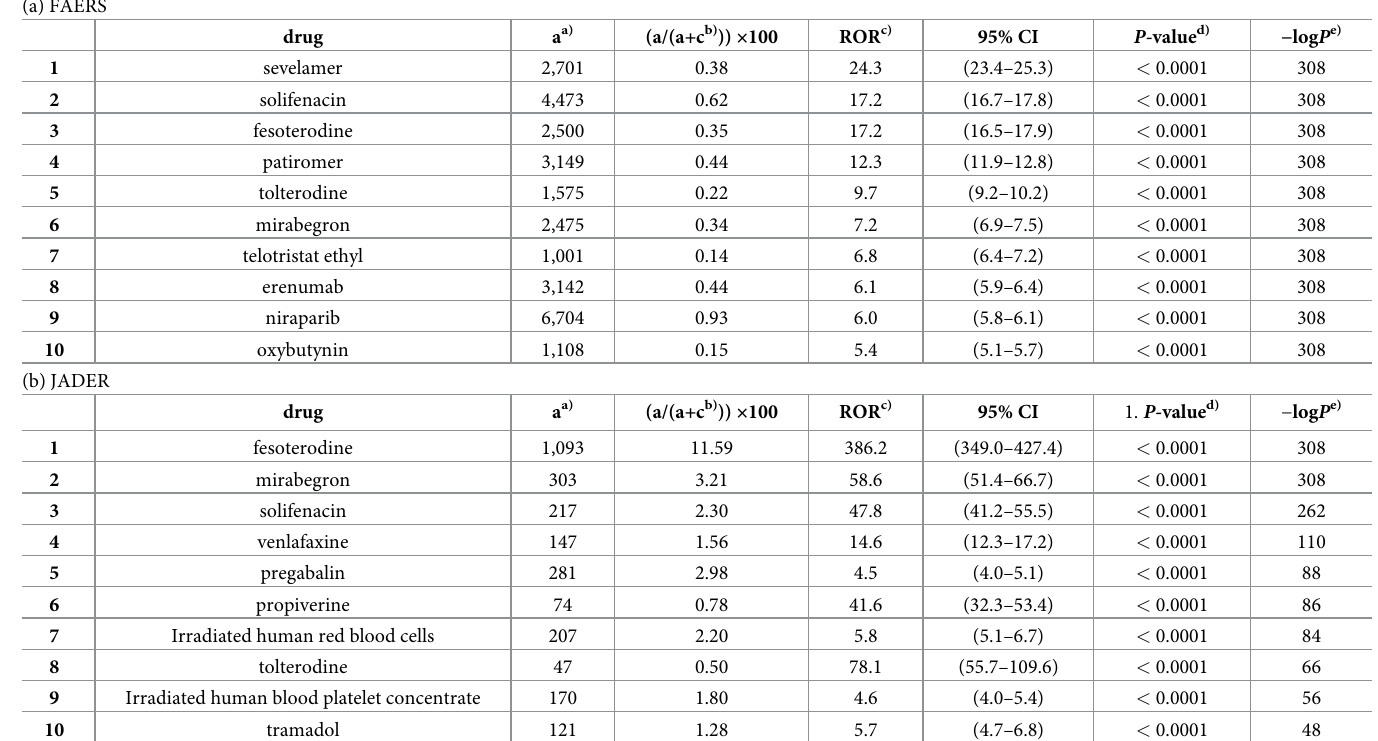
Table 4. Major suspected drugs of PNS. (a) FAERS (b)